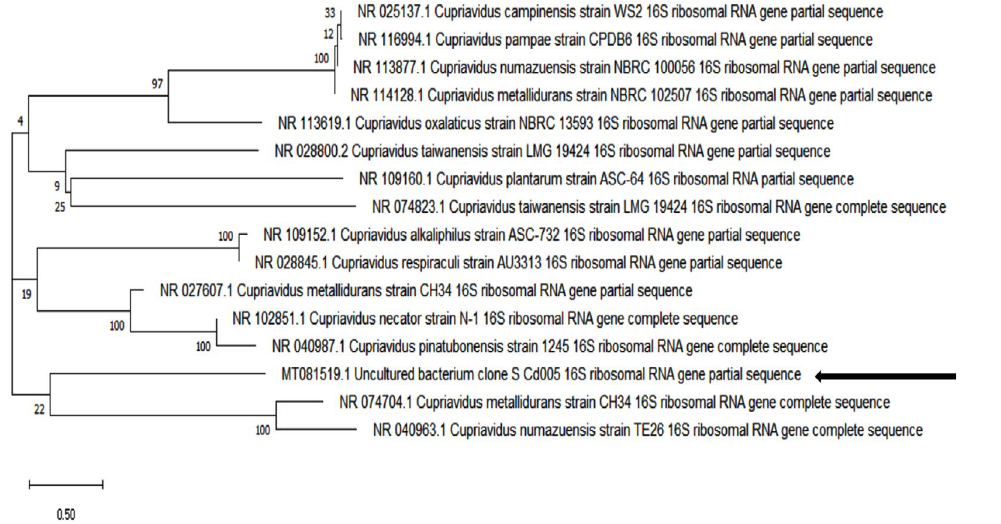
Fig. 1(b). Phylogenetic tree for SCd005.The scale bar indicates 0.5 changes per nucleotide position (evolutionary